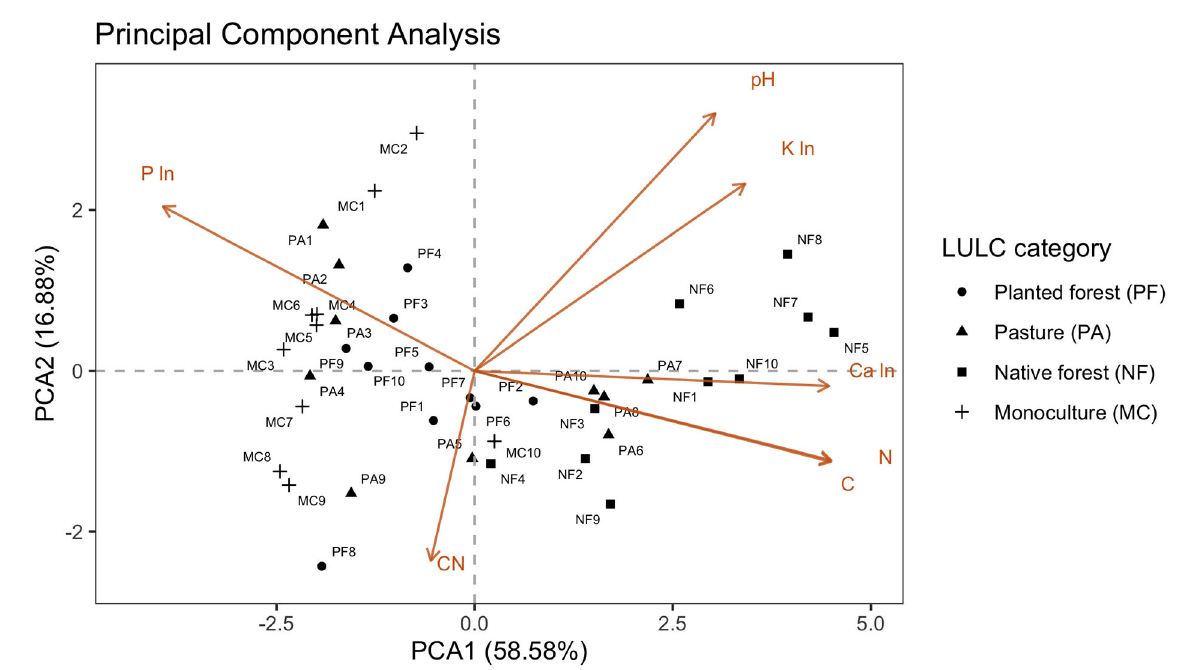
FIGURE6 Principal components analysis of soil chemical parameters by land use category.